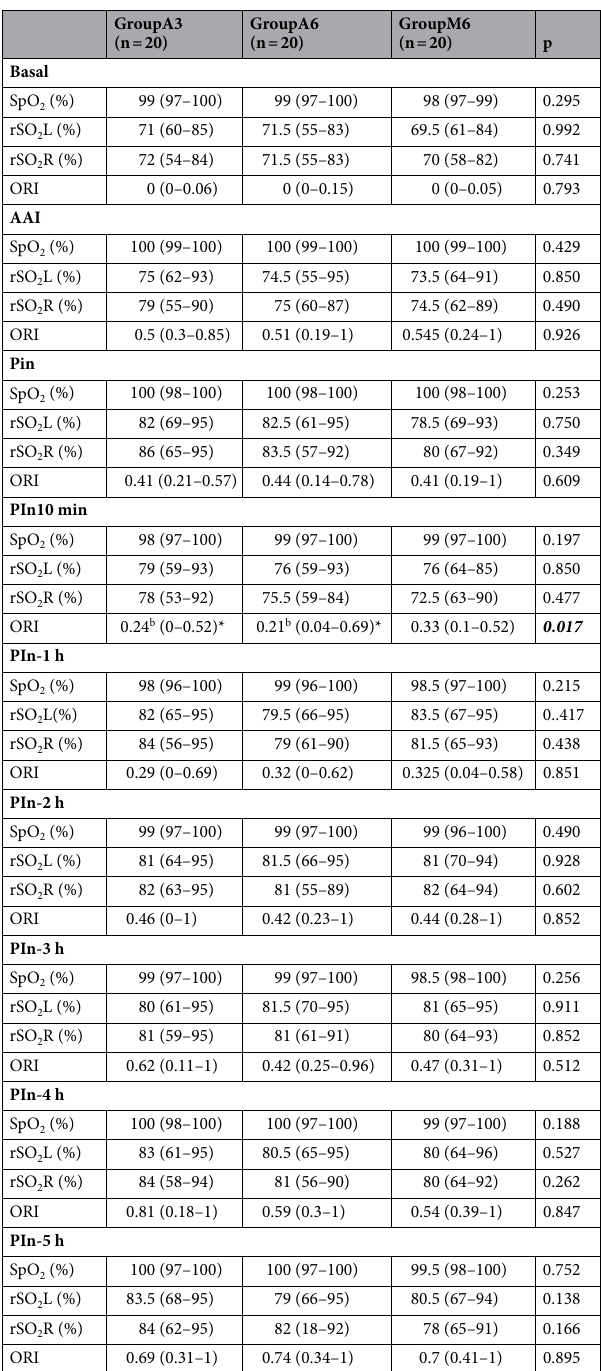
Table 2. Indicators of tissue oxygenation, SpO 2 , rSO 2 L, rSO 2 R, and ORI (median. min–max). AAI, after anaesthesia induction; Pin, post intubation. *a: different according to the A6 group, b: different according to the M6 group. Statistically significant “p” values are in bold and italic.